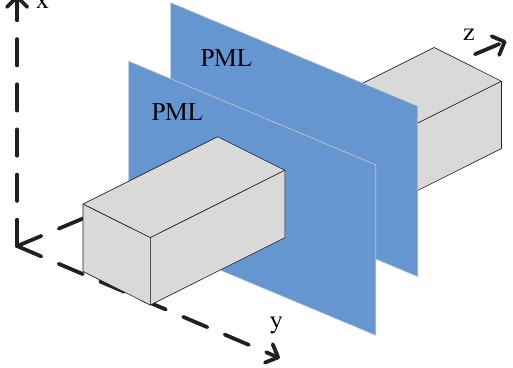
Figure 2. The ROI (gray) and the PML (blue).